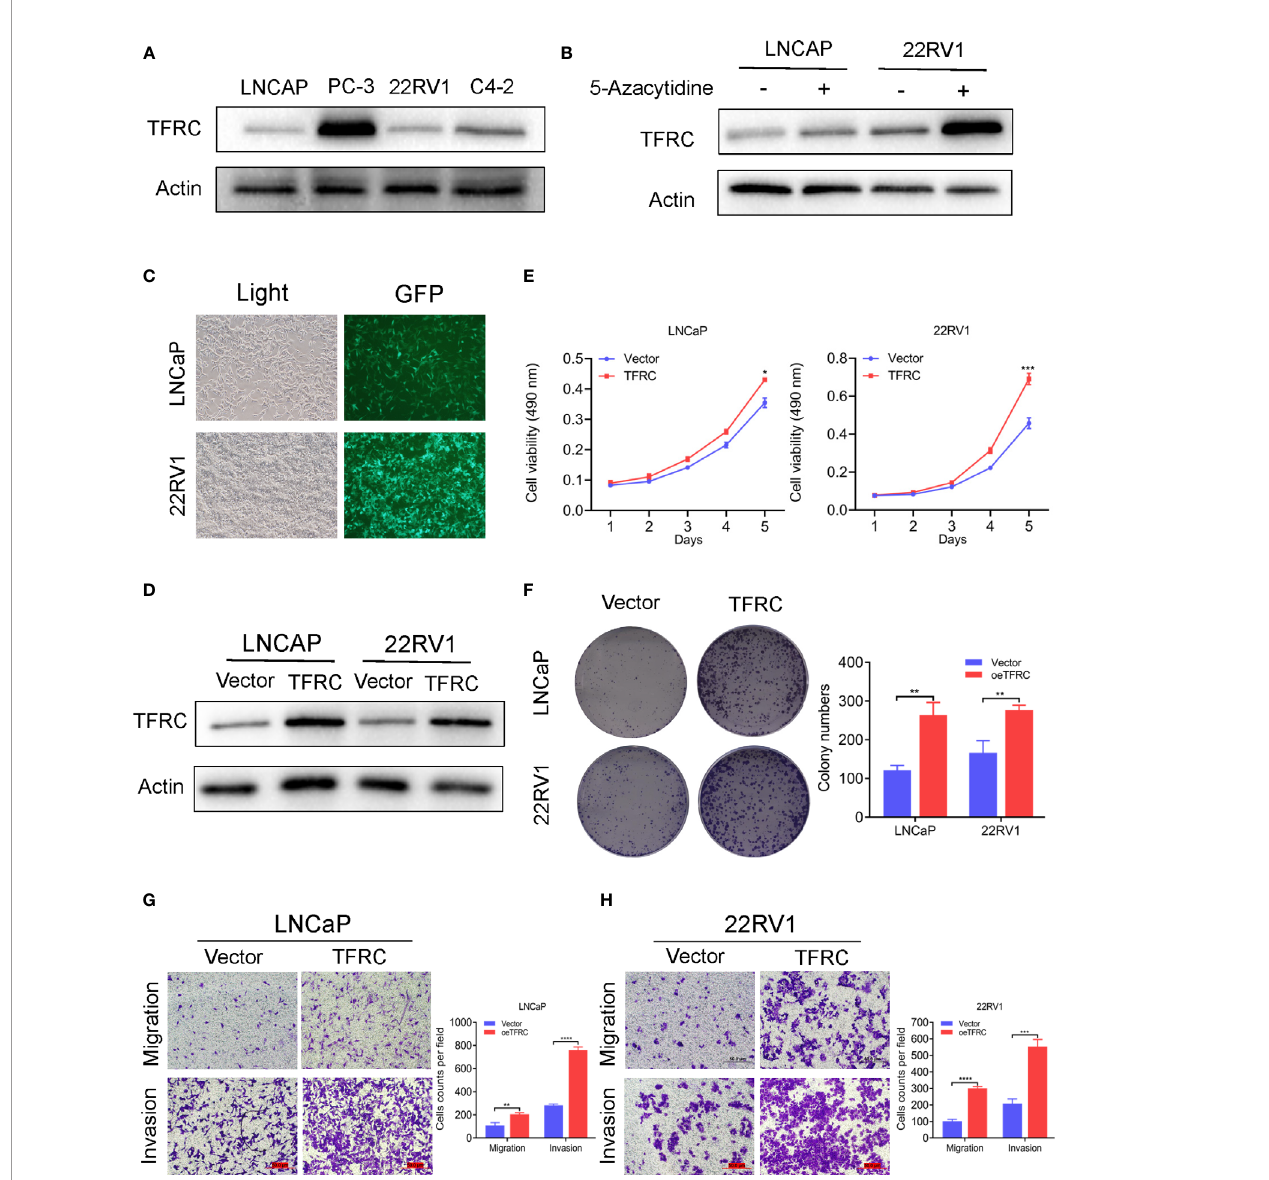
FIGURE 7 | TFRC expression in fl uenced by 5-zacytidine and overexpressing TFRC promotes proliferation, migration and invasion in Pca cells 22RV1 and LNCaP. (A) The protein levels of TFRC in Pca cells (C4-2, LNCaP, 22RV1 and PC-3) were detected by western blots. (B) 5-azacytidine inhibited DNA methylation and increased the expression of TFRC in LNCaP and 22RV1 cells. (C, D) . The ef fi ciency of TFRC overexpressed lentivirus were con fi rmed using fl uorescence microscope and western blots. (E, F) . The MTT and colony formation assays indicated that TFRC promotes cells proliferation in LNCaP and 22RV1. (G, H) . Transwell assays suggested that TFRC promotes cells migration and invasion in LNCaP and 22RV1. *P < 0.05, **P < 0.01, ***P < 0.001, ****P <